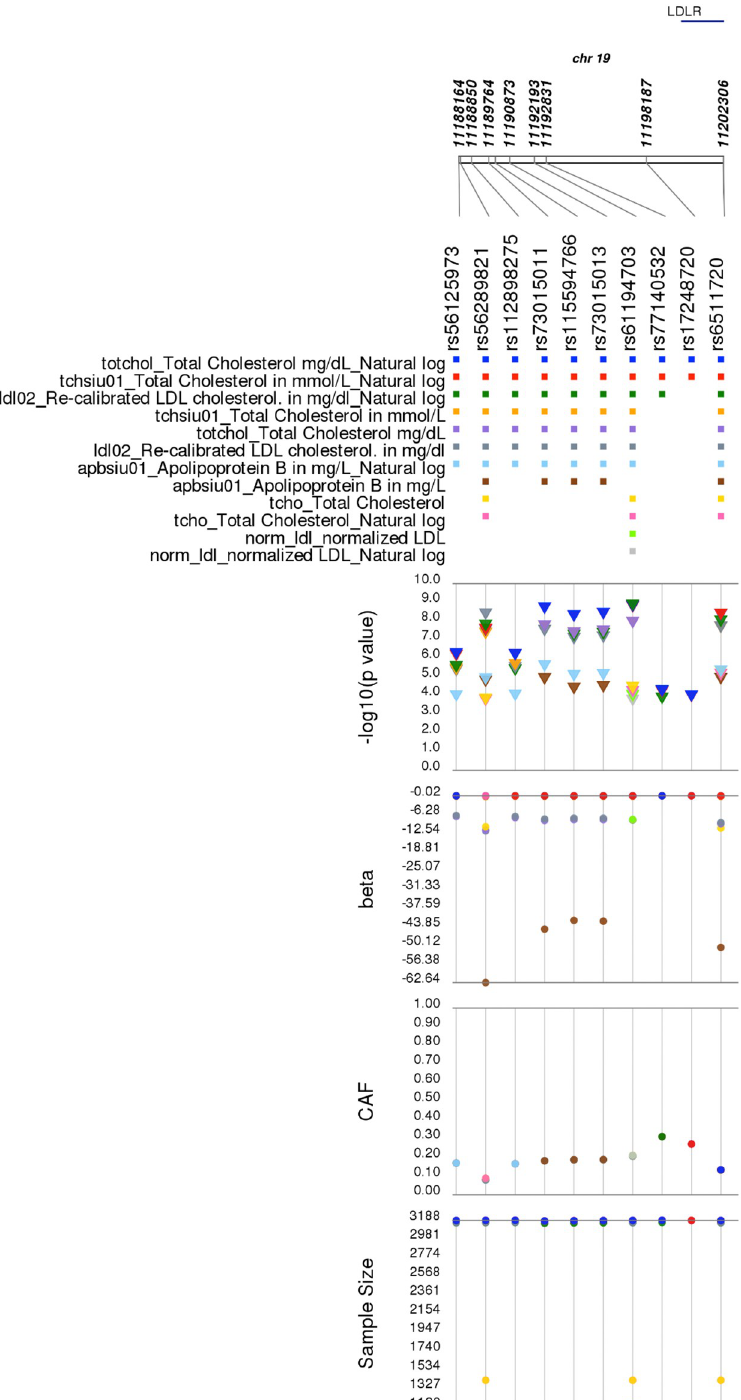
Fig 4. LDLR rs6511720 and nearby single nucleotide polymorphisms associated with lipid-related traits in a single Population Architecture using Genomics and Epidemiology (PAGE) study. Plotted are single SNP tests of association in the Atherosclerosis Risk in Communities (ARIC) for LDLR rs6511720 and nearby SNPs within 100kb of previously-reported genome-wide association study (GWAS) associations also associated here at p < 1.0x10 -4 with lipid-related traits. Data shown are sample size, coded allele frequency (CAF), genetic effect size (beta), -log10(p- value), and ARIC phenotypes on the y-axes. Each SNP is plotted on the x-axis at the top of the figure from 5´ to 3 0 , and